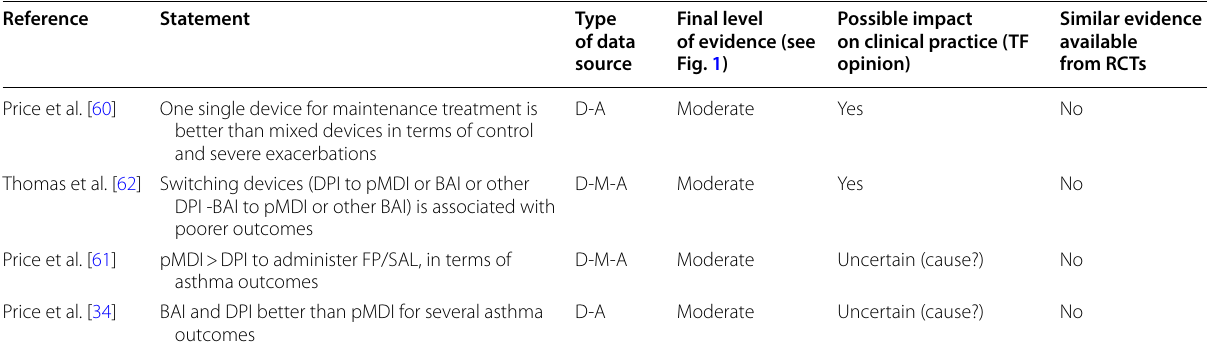
Table 4 Summary table of literature analysis, PICOT question 2: influence of device type for ICS therapy on asthma